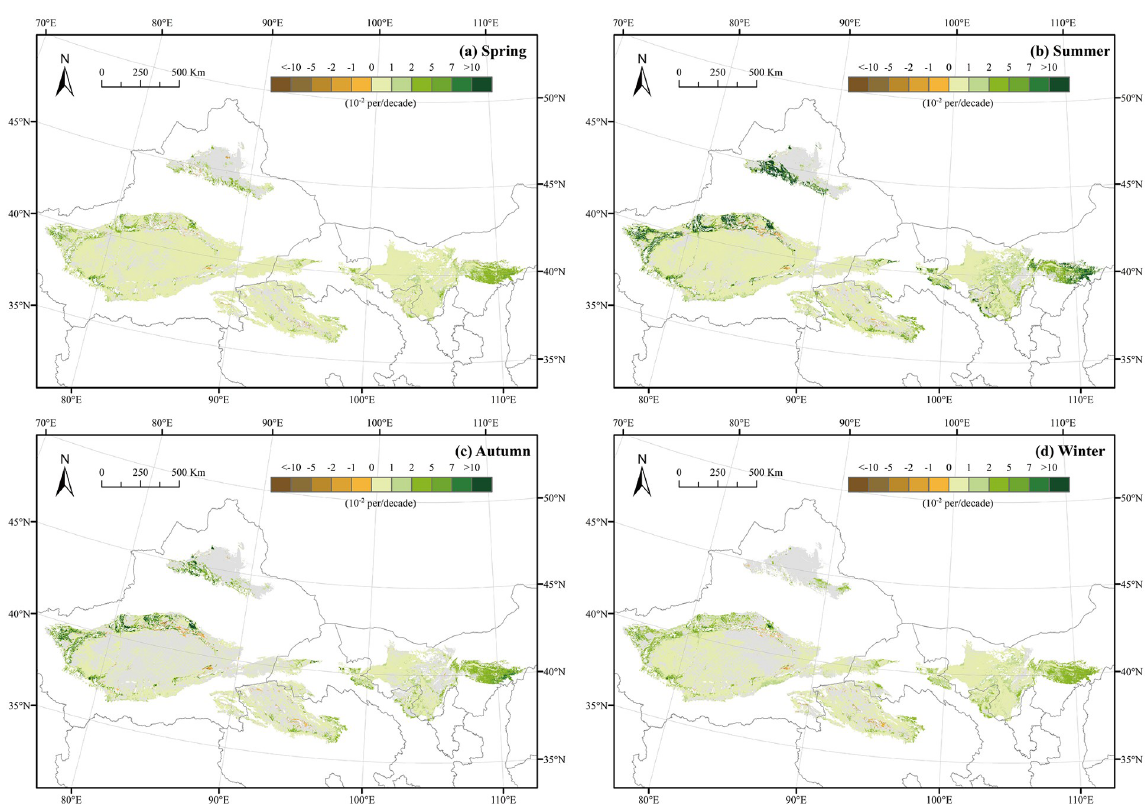
Fig 5. Spatial distribution of greening and browning trends for spring (a), summer (b), autumn (c), and winter (d) in China’s desert areas from 2000 to 2017. Gray areas represent desert regions with no significant trends at the 5% confidence level. The green and brown areas indicate that the pixel has a significant greening and browning trend, respectively.